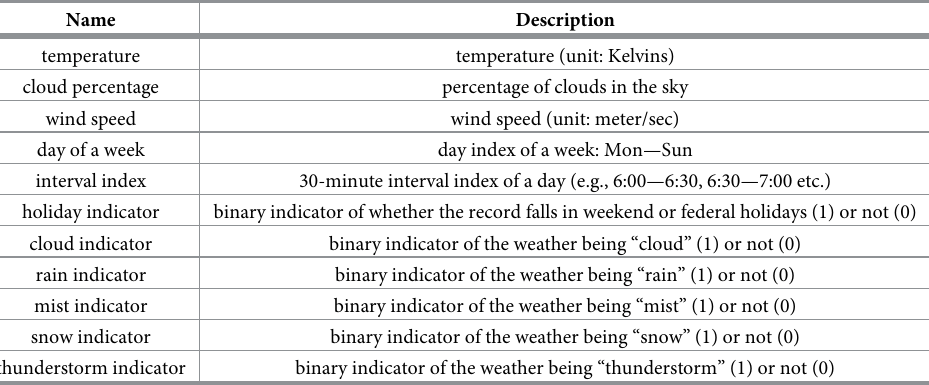
Table 2. Independent variable list. The first three variables are numerical, and the remaining are